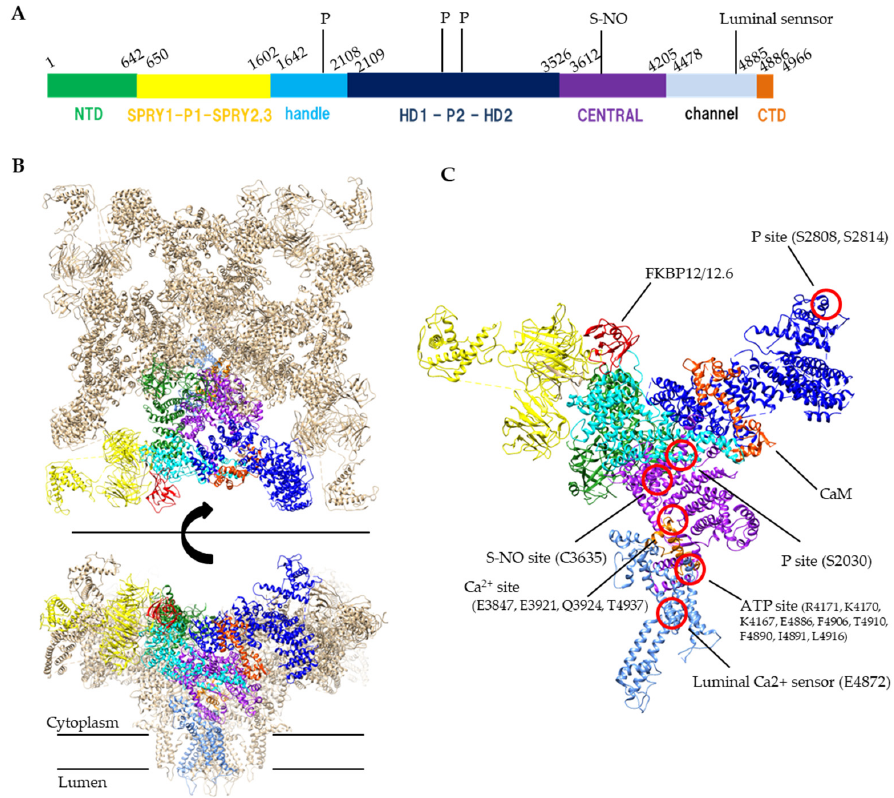
Figure 1. Structure of RyR. ( A ) A schematic illustration of domain organization of mouse RyR2. ( B ) Structure of the tetrameric RyR2 in complex with FKBP12.6 and calmodulin, looking from the cytoplasmic side (top) or parallel to the membrane (bottom). PDB code: 6JI8. ( C ) Structural details of domain organization and modification sites in one protomer. S-NO site and p site indicates s-nitrosylation site and phosphorylation sites, respectively. Domain colors correspond to a schematic illustration of A, NTD (residues 1–642) colored forest green, SPRY1-P1-SPRY2-SPRY3 (residues 650–1602) colored yellow, handle (residues 1642–2108) colored cyan, HD1-P2-HD2 (residues 2109–3526) colored blue, CENTRAL (residues 3612–4205) colored purple, channel region (residues 4478–4885) colored light blue, CTD (residues 4886–4966) colored orange. FKBP12.6 and calmodulin (CaM) are colored red and orange red, respectively.